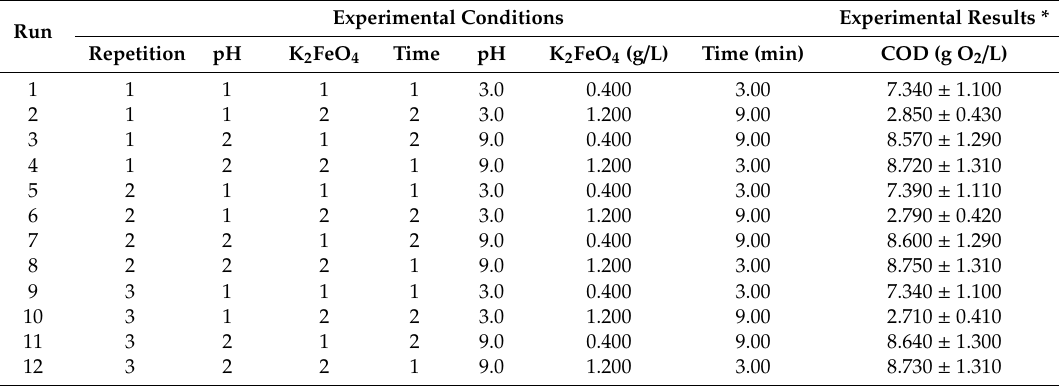
Table 2. Experimental conditions (factors and levels of the orthogonal array) and results (COD as value ± expanded uncertainty) for tannery wastewater (pH 1 = 3.0, pH 2 = 9.0, K 2 FeO 4 (1) = 0.400 g /